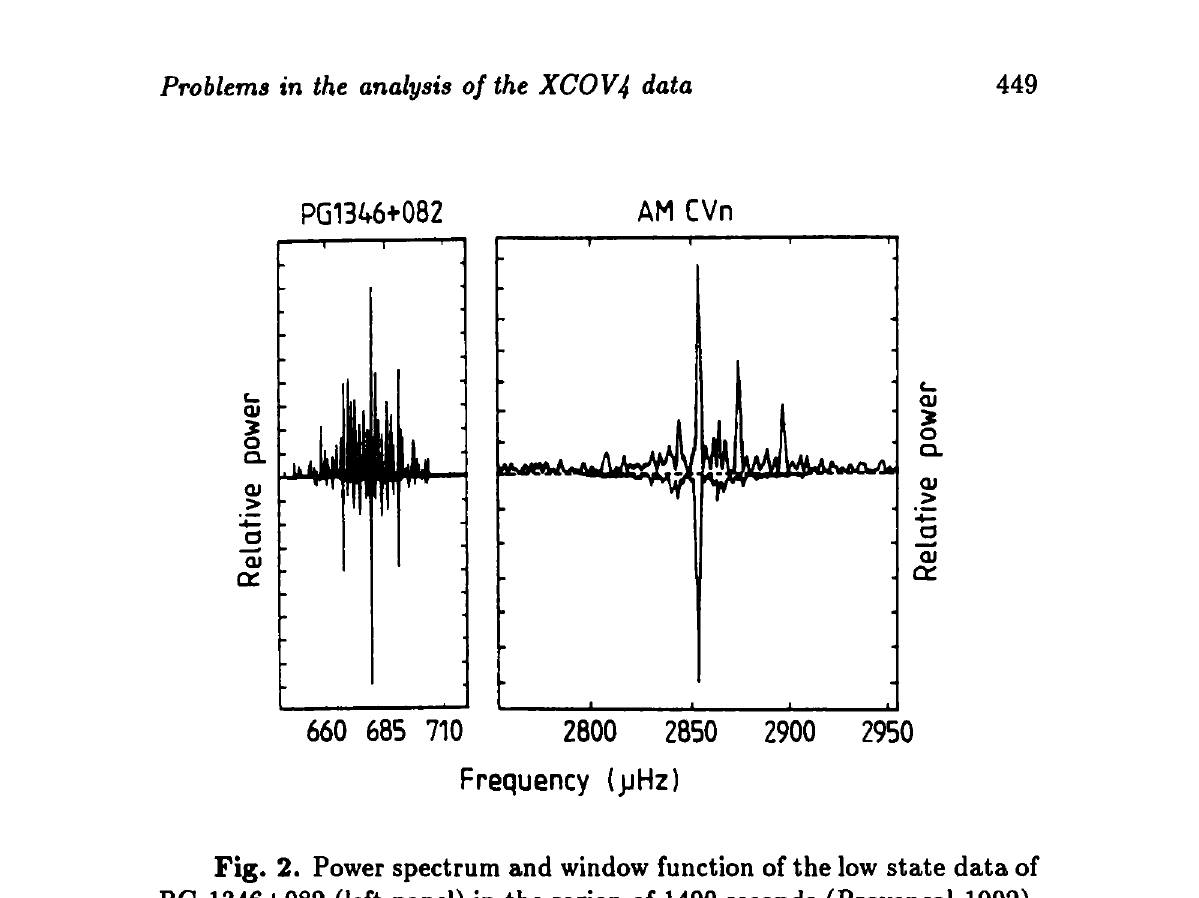
Fig. 2. Power spectrum and window function of the low state data of PG 1346+082 (left panel) in the region of 1490 seconds (Provencal 1992), and power spectrum and window function in the region of 350 s for AM CVn (right panel). The window function is shown